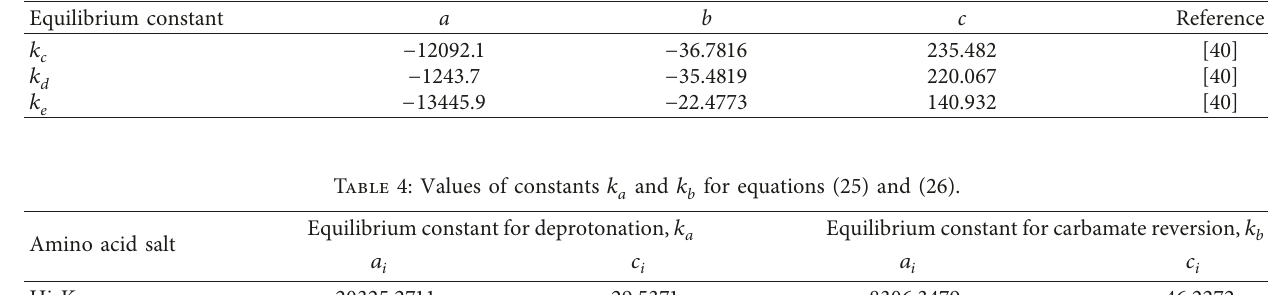
Table 5: Values of constants f